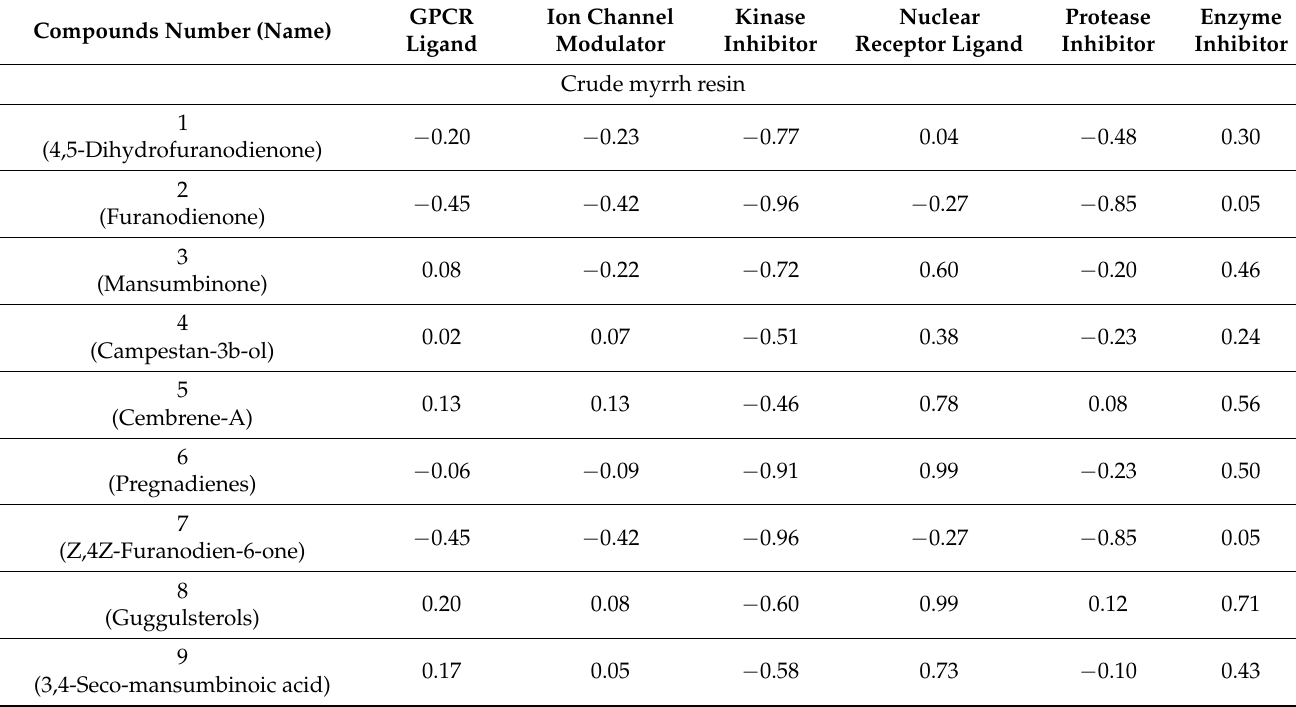
Table 4. Target prediction of crude myrrh resin using Molinspiration